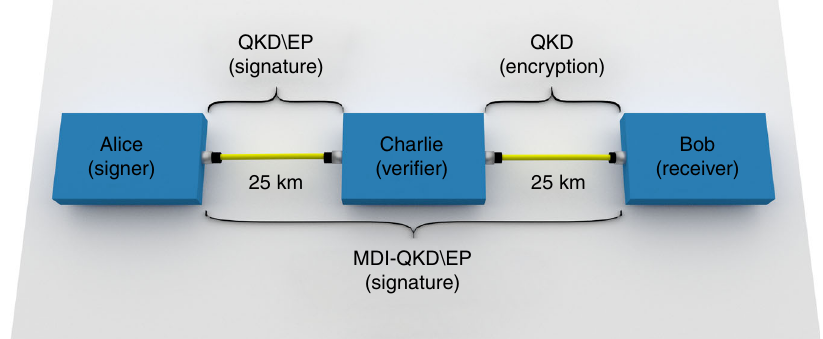
Fig. 4 MDI-QKD-mediated QDS. The signature is sent by Alice to Bob using an MDI-QKD setup, over an optical fi bre with a total length of 50 km. The protocol is denoted “ MDI-QKD\EP ” , where “ \EP ” stands for “ without error correction and privacy ampli fi cation ” . QKD\EP is used to send a signature from Alice to Charlie, whereas full QKD is used to distribute keys between Bob and Charlie to allow for the symmetrisation step of QDS (see Supplementary Note 1). The QKD links are implemented with two 25-km reels of single-mode fi